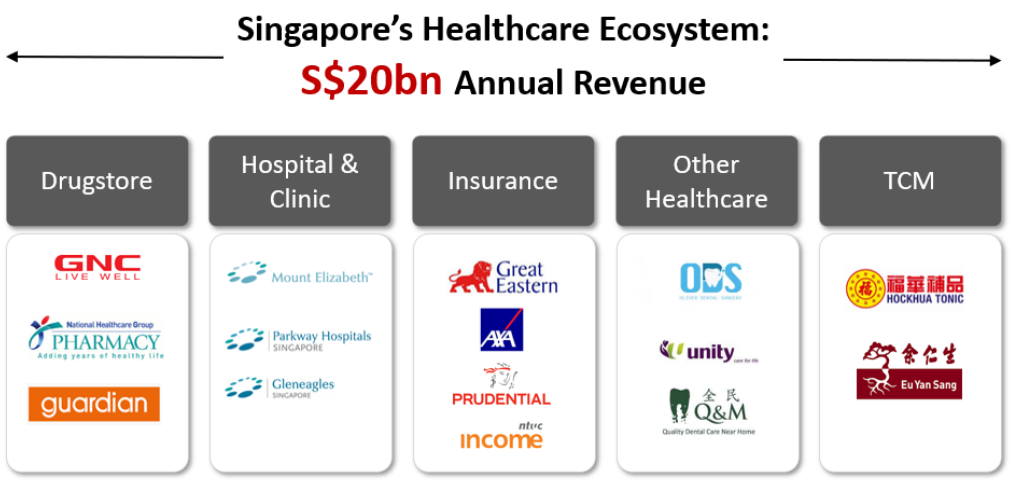
Figure 16. Top merchants identified for each category.